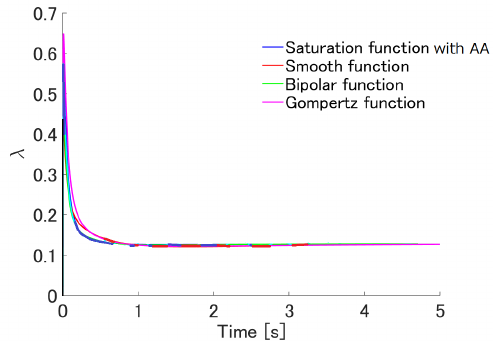
Figure 14. Time response of driving torque on wet asphalt